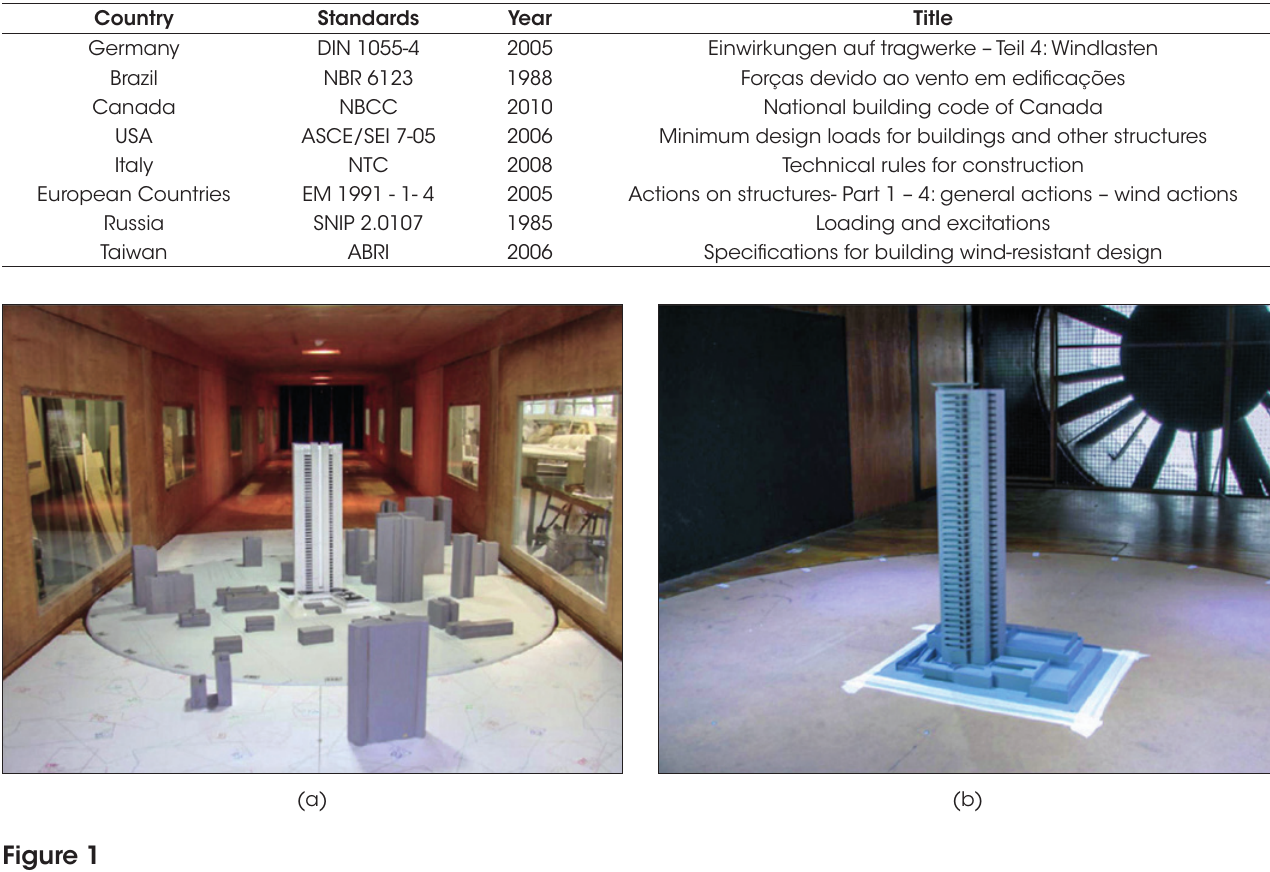
Wind tunnel lab (a) LAC [7] and (b) IPT